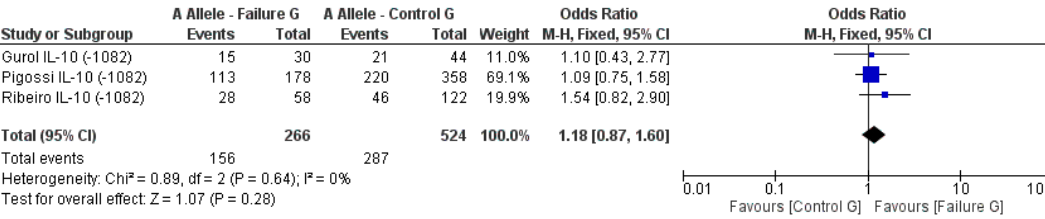
Figure 5. Odds ratio and forest plot for the prevalence of IL10-A1082 allele in the failure group (at least one implant failure) vs. control group (without implant failure). The OR of the combined data crossed the line of no difference.